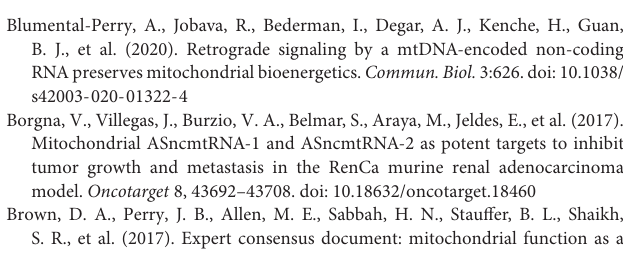
Supplementary Table 2 | Metabolic analysis of TCA intermediates. Supplementary Table 3 | Mitochondrial stress test kit data